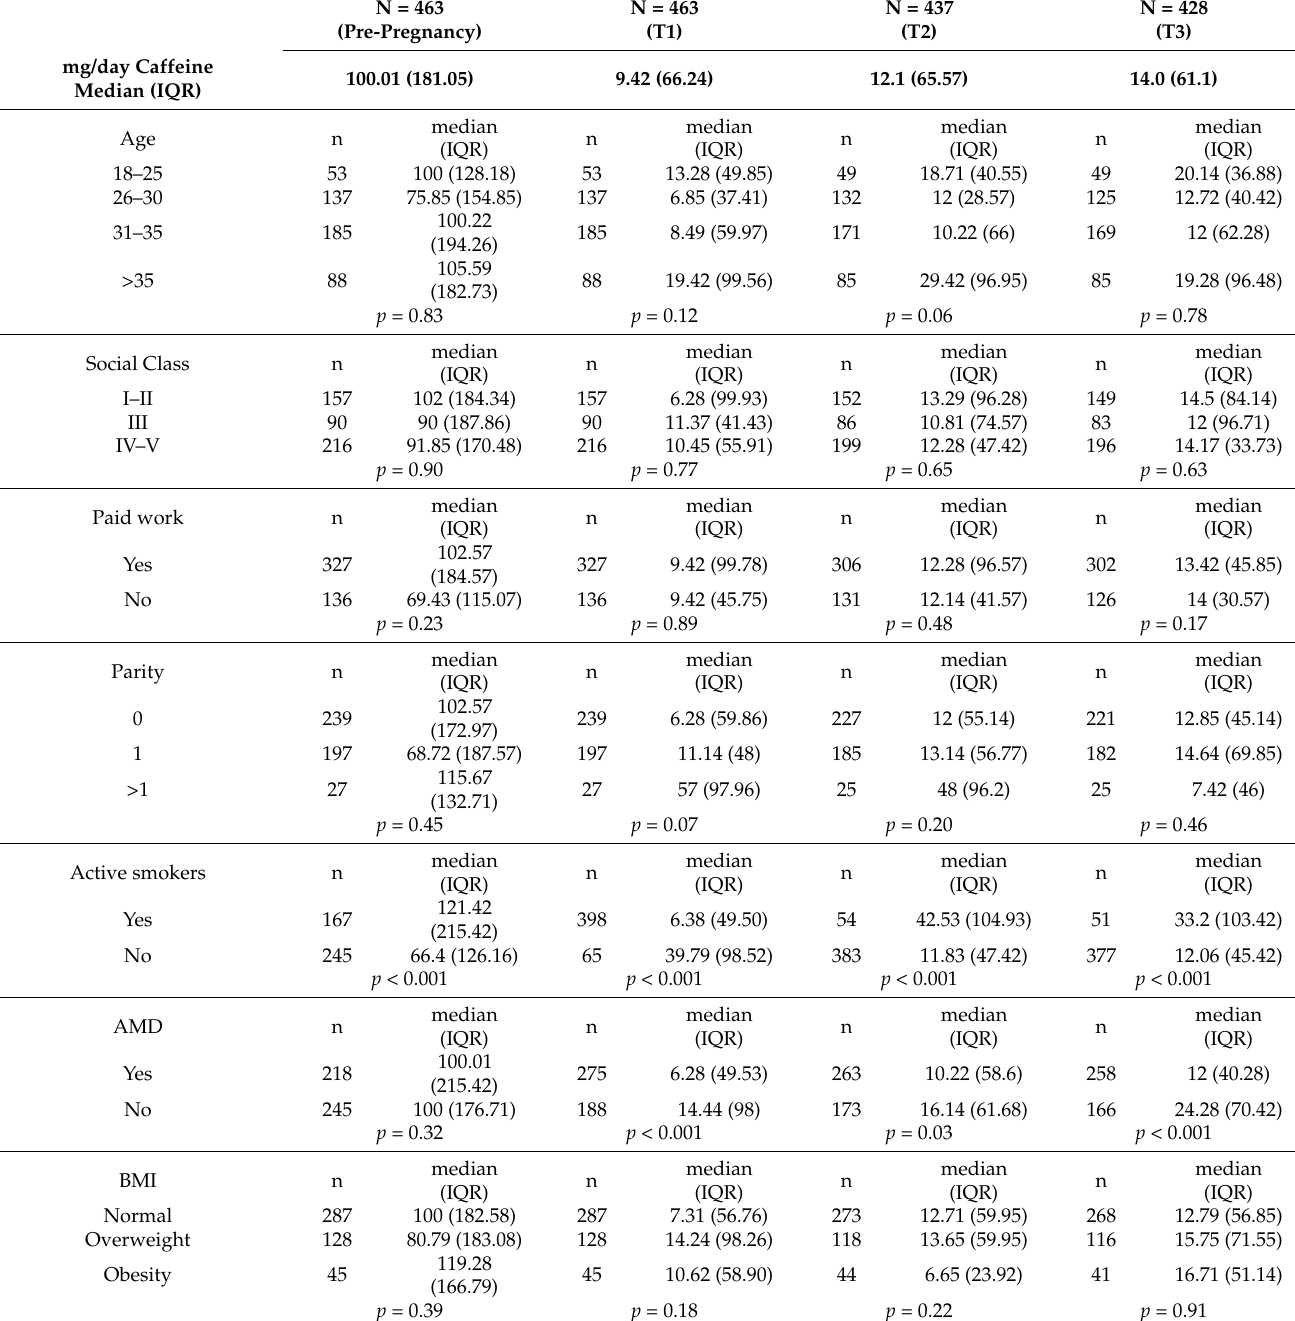
Table 1. Median and interquartile range of caffeine intake before and during